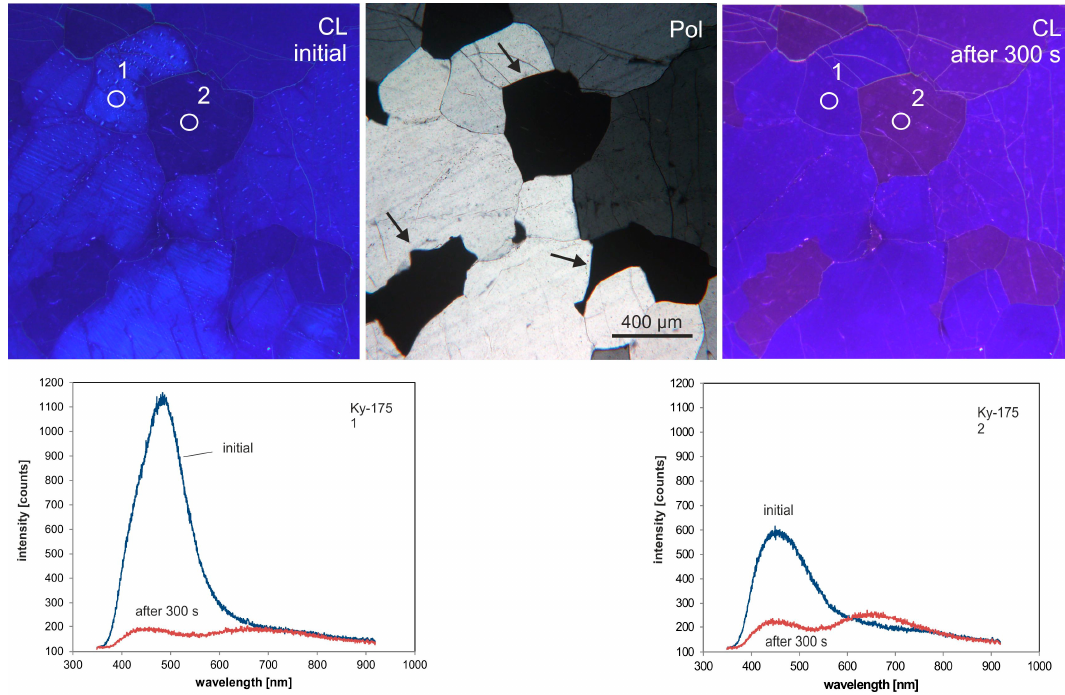
Figure 5. Micrographs in cathodoluminescence (CL) and transmitted light (crossed polars—Pol) of the hydrothermal quartz from Kyshtym (Ky-175); the images and related spectra show the initial CL and the CL after 5 min of electron irradiation. Note the different CL behaviour of quartz sub-grains with varying crystallographic orientation; sub-grains cut perpendicular to the crystallographic c-axis (see arrows) have a lower initial blue CL intensity and develop a reddish CL (650-nm emission band) due to the electron bombardment.